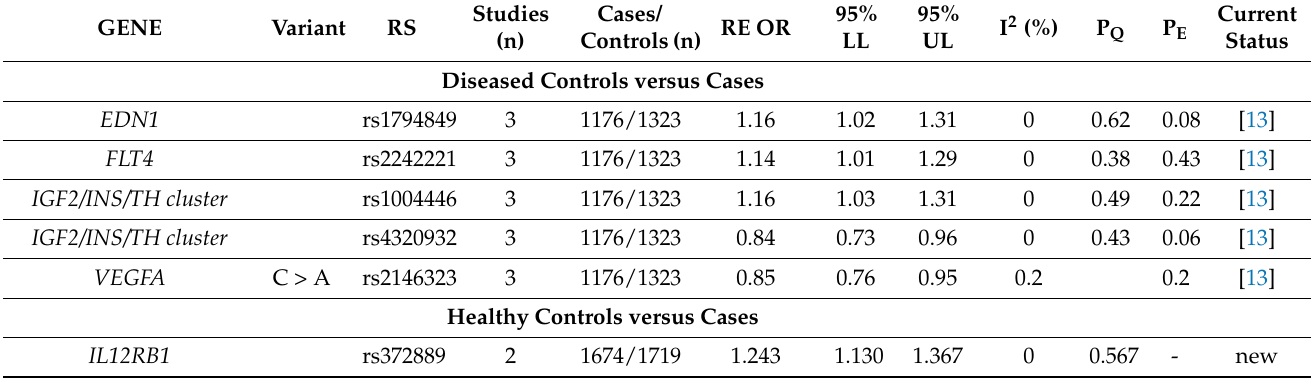
Table 3. Results of the meta-analyses of statistically significant polymorphisms listed in alphabetical order based on allele